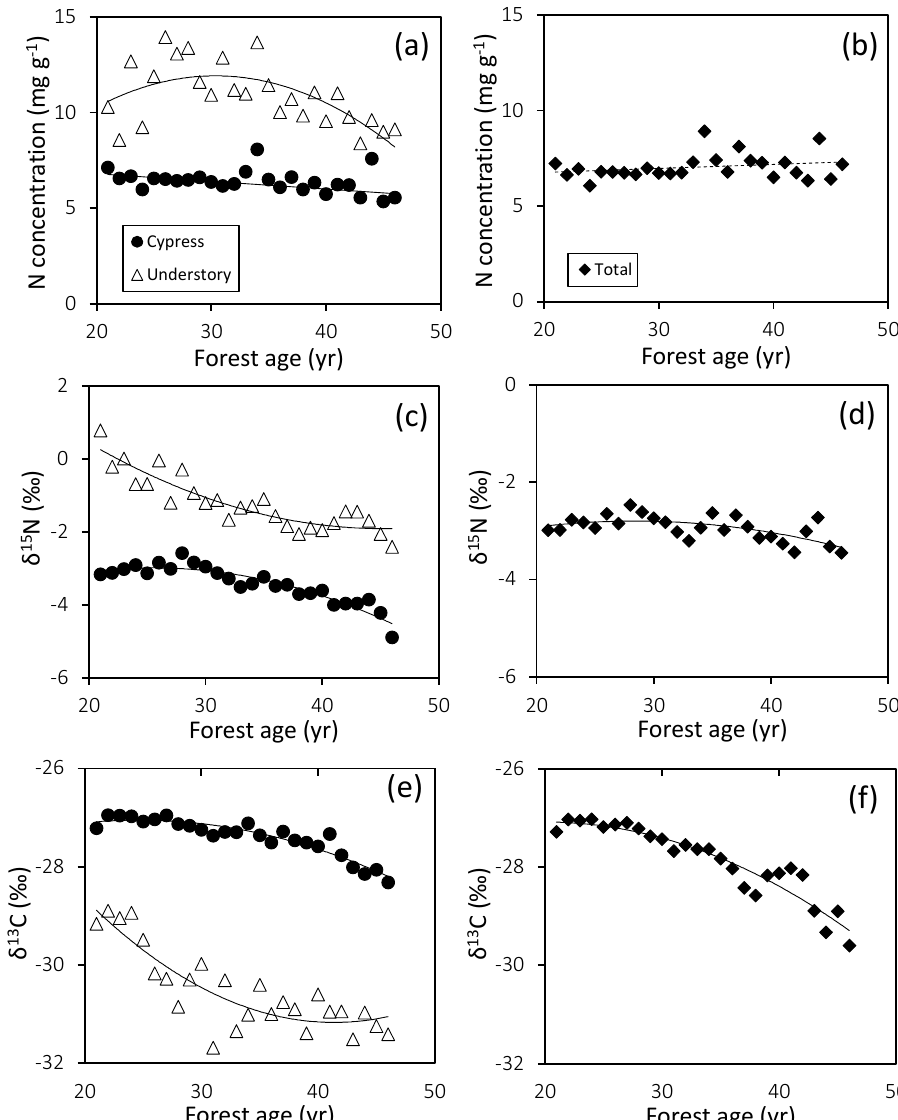
Figure 3. Leaf litter nitrogen concentration ( a , b ), leaf δ 15 N ( c , d ), and leaf δ 13 C ( e , f ) of hinoki cypress and understory vegetation in relation to forest age.